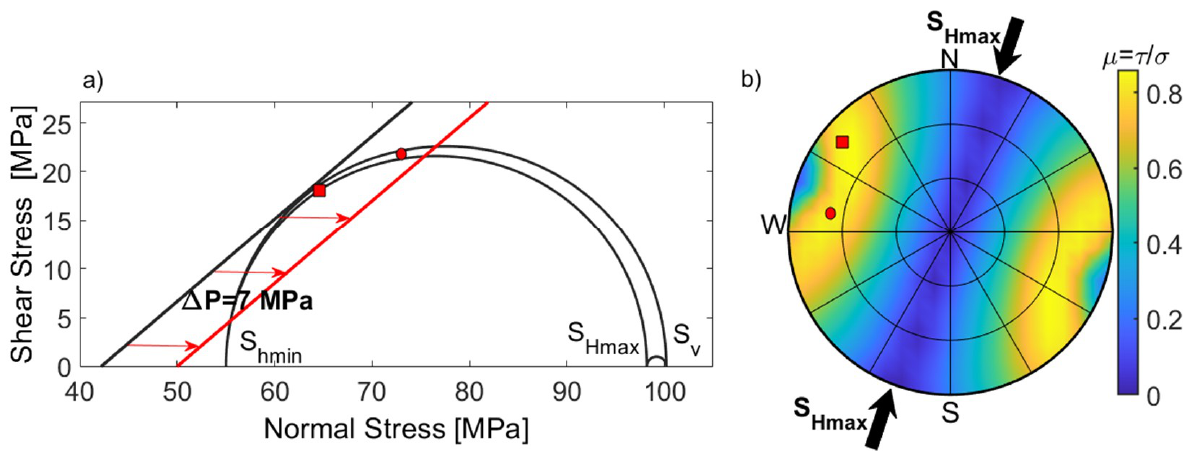
Figure 5. ( a ) 3D Mohr circles showing stress condition and slip tendency due to fluid injection in the deep geothermal reservoir Groß Schönebeck in the North German Basin. The red line is the Coulomb failure criterion when pore pressure has been elevated by 7 MPa, and ( b ) The lower hemisphere stereonet plot illustrates the slip-tendency (ratio of resolved shear to normal stress) and stress direction.